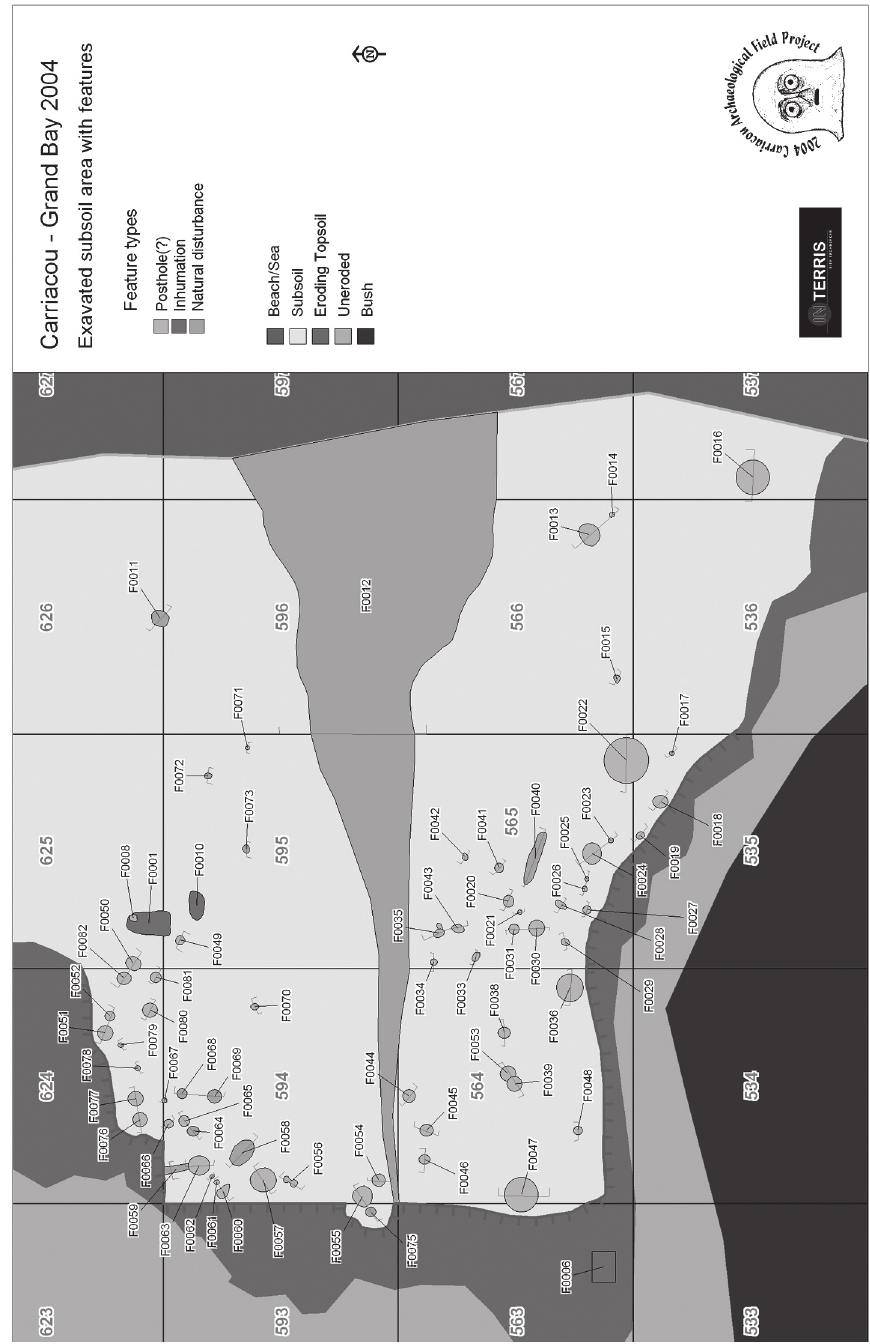
Figure 5. Plan of features uncovered in the sub-soil at Grand Bay (Michiel Kappers, In-Terris Site